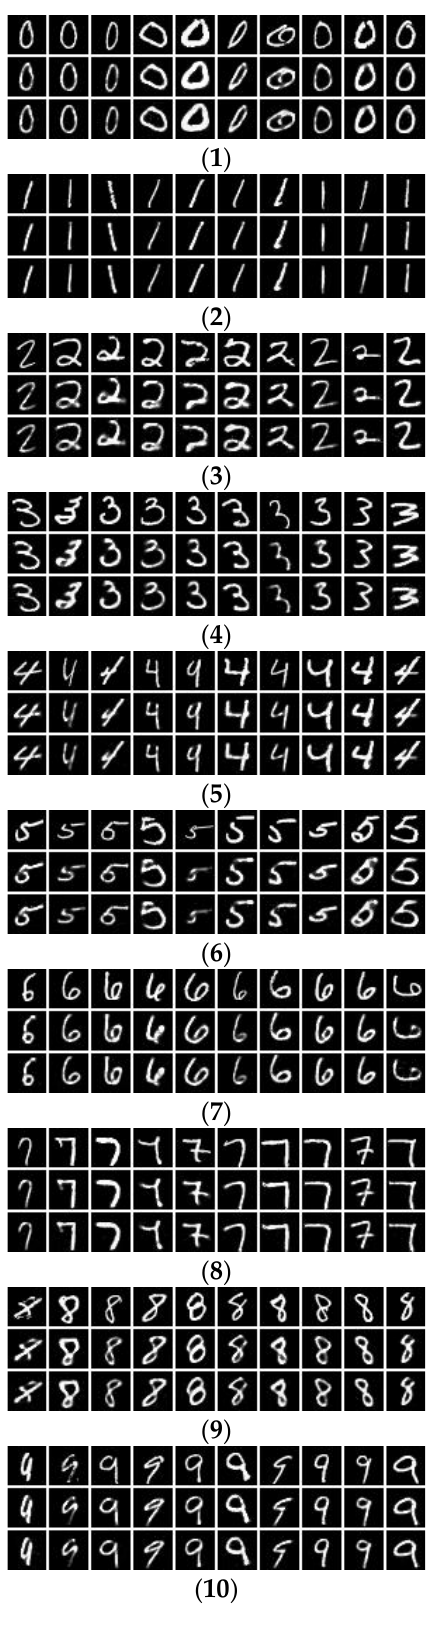
Figure 16. Reconstruction images on the MNIST data set. For each subfigure, the top row shows the original images, the middle row shows the recovery images of AE, and the bottom row shows the recovery images of RCDAE.